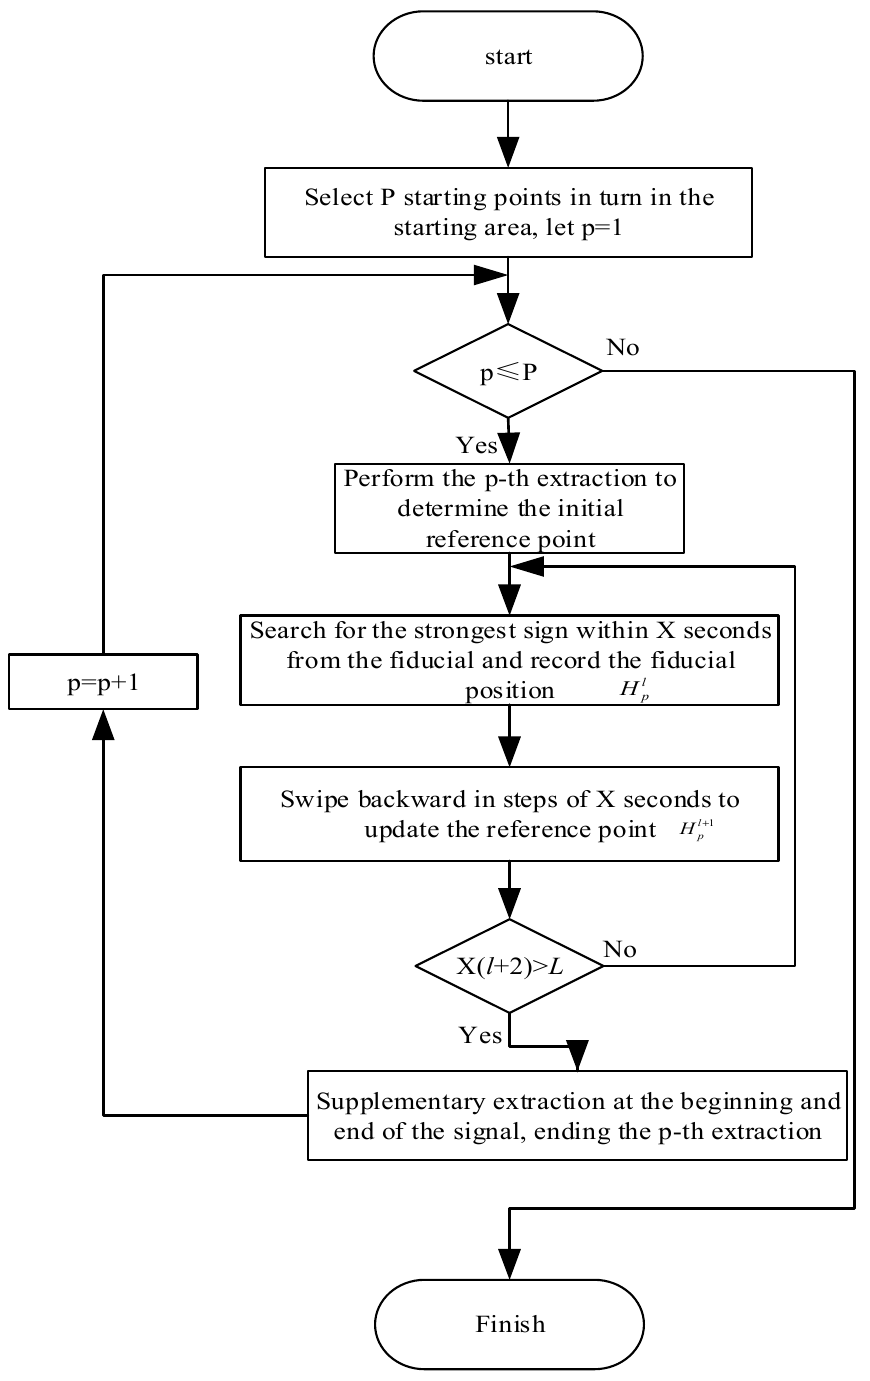
Figure 3. Signal acquisition process. After a large number of tests in MATLAB, different P values were selected for physical sign information with a total length of 30 s for strong sign extraction, VMD decomposition, and breathing and heartbeat signal extraction. After several experiments and comparisons,